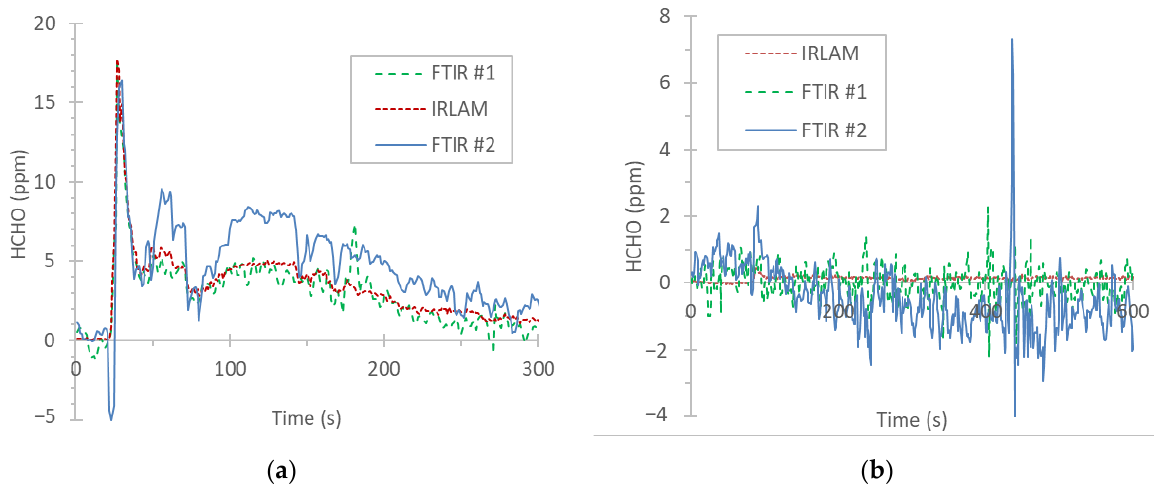
Figure 5. Real time tailpipe concentrations ( a ) CH 4 over a cold start WLTC of the gasoline Euro 4 (G4) vehicle; ( b ) HCHO during a cold start RDE_D of the Diesel Euro 6 (D6) vehicle.